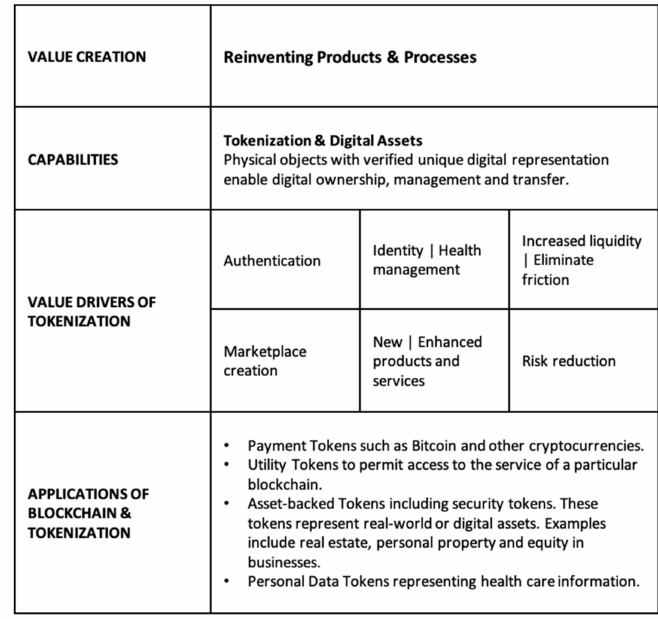
Figure 1. Blockchain and tokenization value